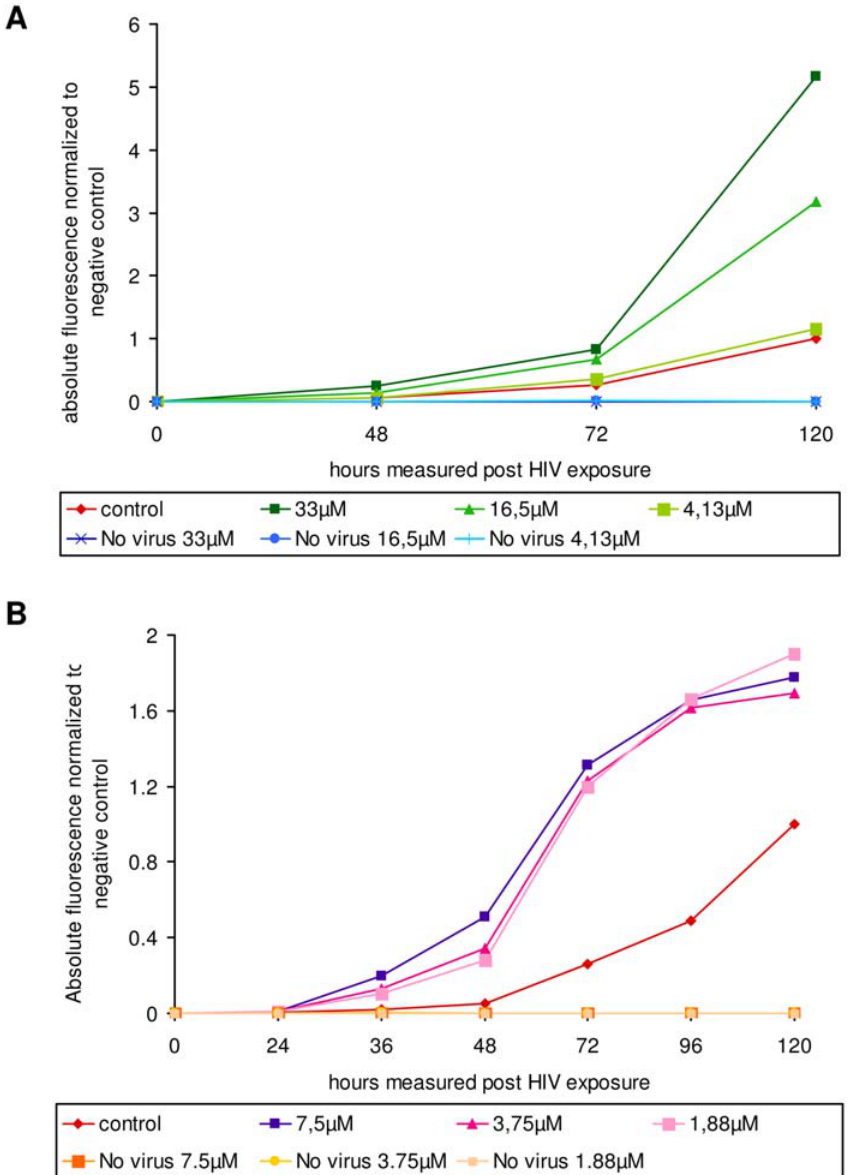
Figure6. INrpeptides stimulate HIV-infectionof LC5-RIC cultures . LC5-RIC reporter cells contain an integrated reporter genefor HIV-dependent production of a redfluorescent protein. LC5-RIC cultures were incubated with HIV-1 IIIB andpeptide INr-1 (A) or INr-2 (B) at theindicated